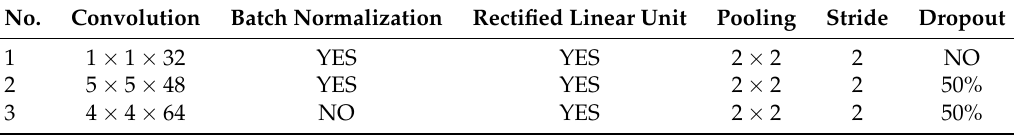
Table 1. Architecture of the CNN.